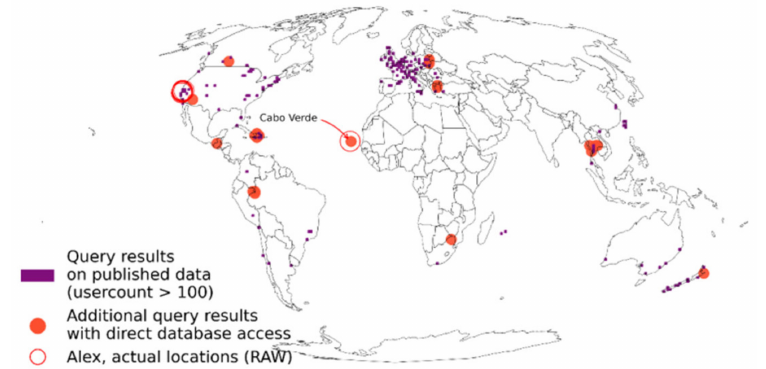
Figure 9. Alex case study, evaluation of scenario